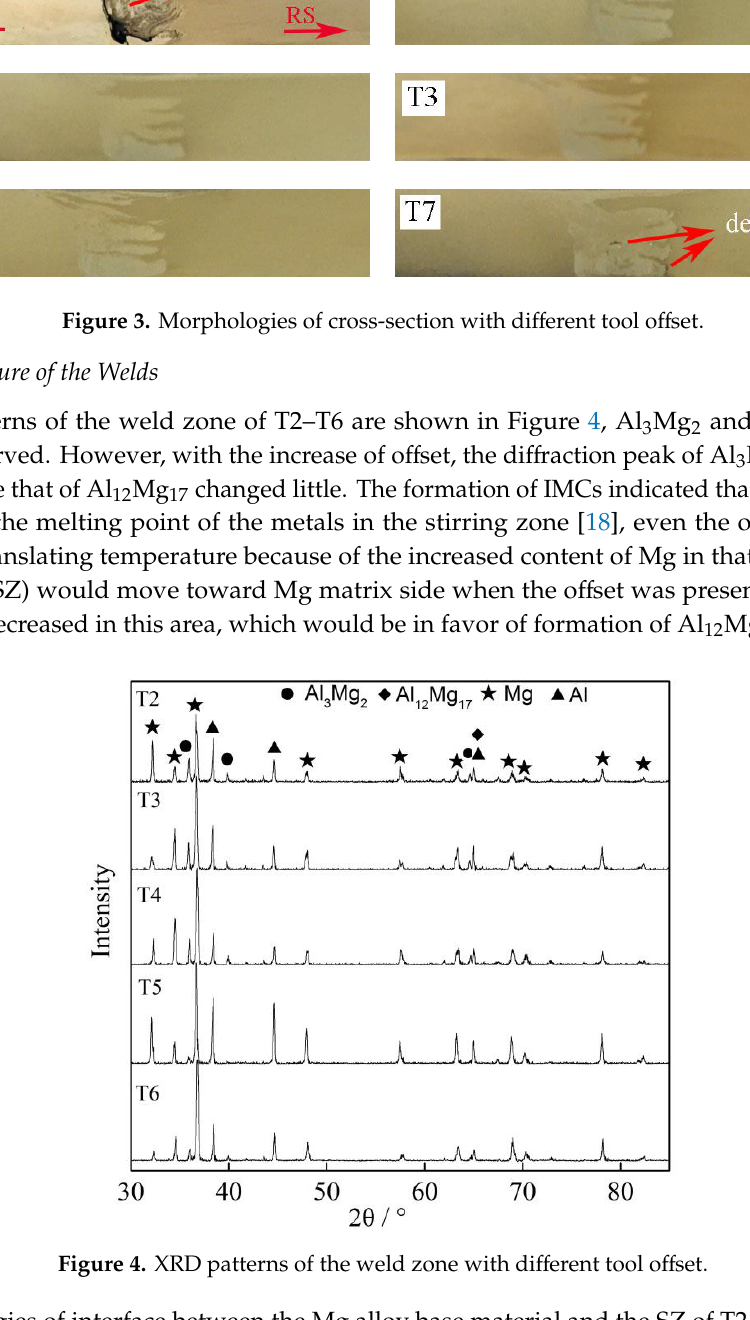
Figure 2. Surface morphology of the welds at different tool offset.